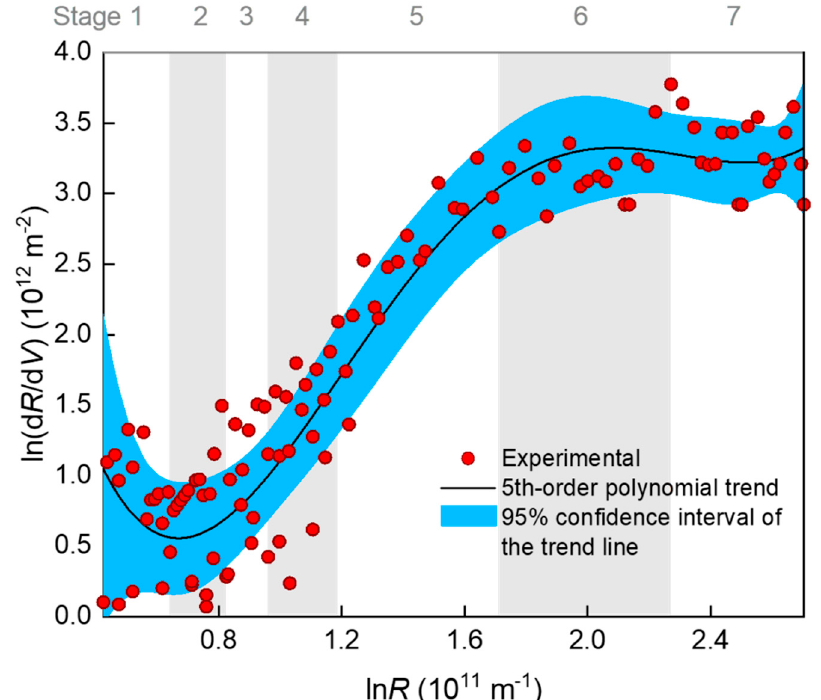
Figure 4. Relationship between d R / d V and R (filtration resistance) during the filtration process. The R-squared value of the 5th order polynomial fitting was 0.907. The 95% confidence interval of the 5th order polynomial trend line was produced using a 999-times Monte Carlo simulation based on the distribution of residuals.